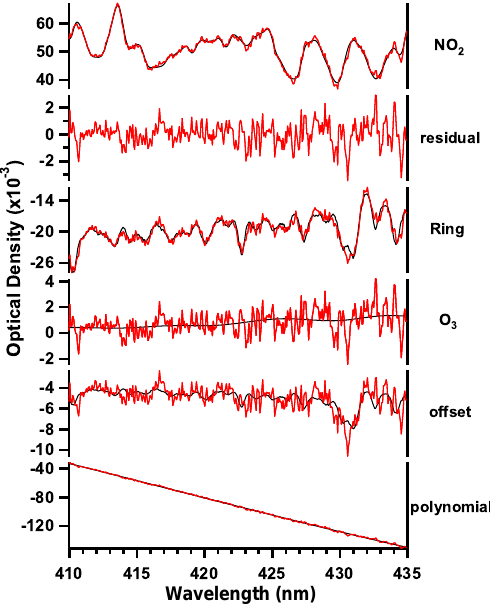
Fig. 2. NO 2 MAX-DOAS fit retrieval for a measurement with α = 4 ◦ on 20 June 2007, 09:46EDT. This fit, performed between 410–435nm, includes the NO 2 and O 3 absorption cross sections, plus a 3rd order polynomial, offset polynomial, FRS, and Ring. The residual of the fit is shown in the second panel. For each remain- ing panel the black line represents the DOAS fit, and the red line represents the DOAS fit plus the residual of the species